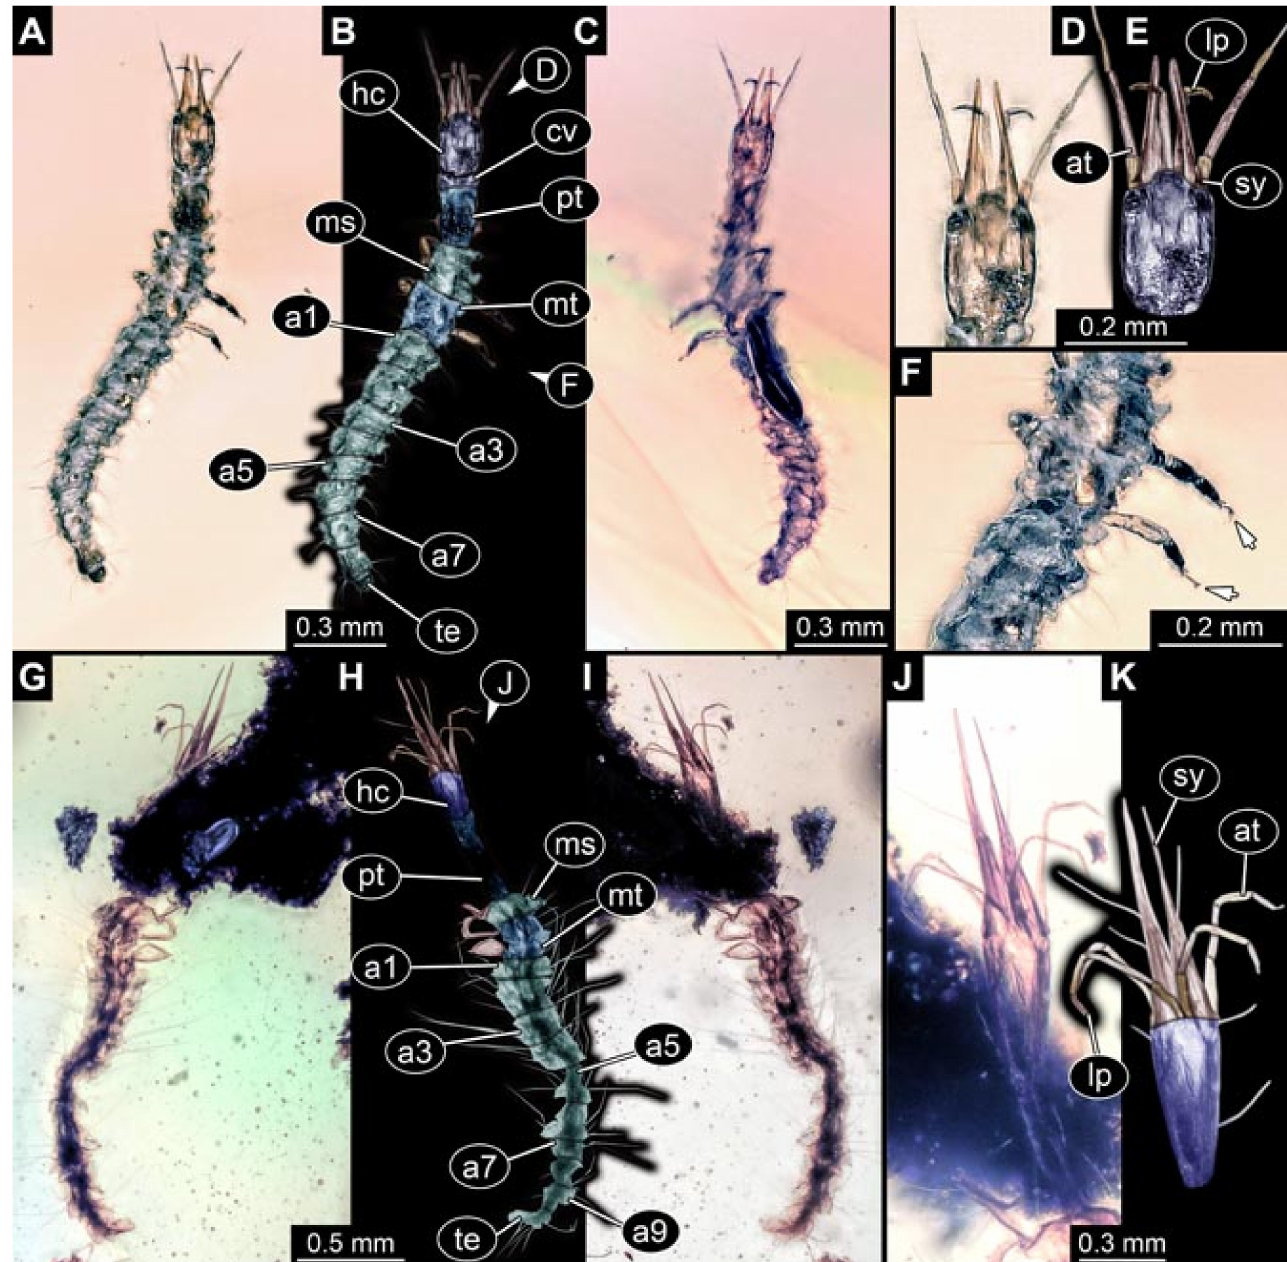
Figure 7. Specimens in Myanmar amber. ( A – F ) Specimen 5827 (BUB 3355). ( A ) Dorsal view. ( B ) Dorsal view, colour-marked. ( C ) Ventral view. ( D ) Close-up of head capsule in dorsal view. ( E ) Close-up of head capsule in dorsal view, colour-marked. ( F ) Close-up of trunk appendages with empodia (arrows). ( G – K ) Specimen 5828 (BUB 3390). ( G ) Supposed dorsal view. ( H ) Supposed ventral view, colour-marked. ( I ) Supposed ventral view. ( J ) Close-up of head in ventral view. ( K ) Close-up of head in ventral view, colour-marked. Abbreviations: a1–a9 = abdomen segment 1–9; at = antenna; cv = cervix; hc = head capsule; lp = labial palp; ms = mesothorax; mt = metathorax; pt = prothorax; sy = stylet; te = trunk